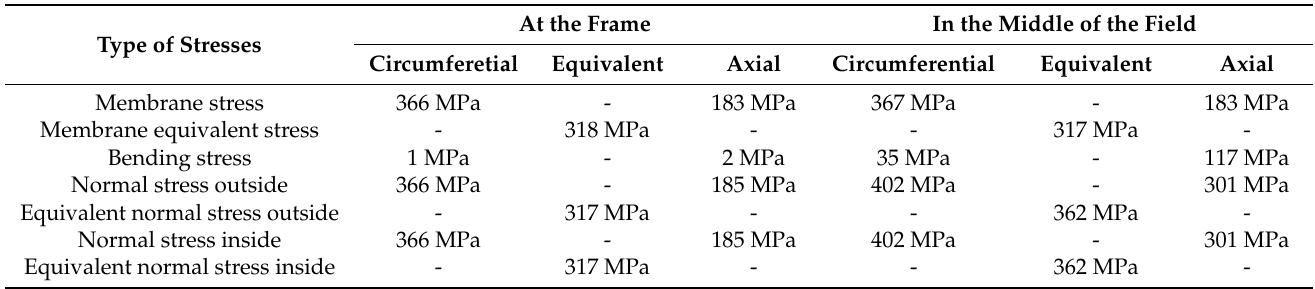
Table A4. Stresses at the collapse diving depth 565 for the SFG baseline design in the free flooding compartment.